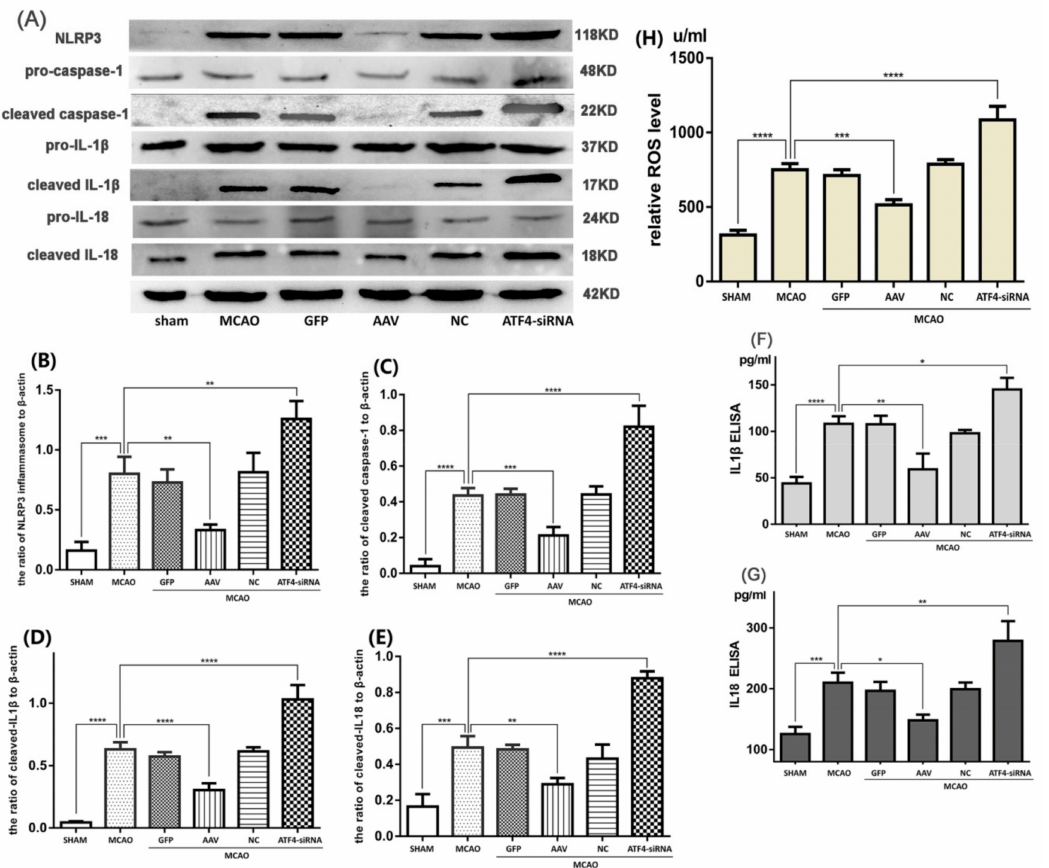
Figure 2. ATF4 a ff ects NLRP3 inflammasome-mediated inflammatory response during cerebral I / R injury. ( A – E ) Representative Western blots showing protein levels of NLRP3 protein, cleaved-caspase-1, cleaved-IL-1 β and cleaved-IL-18. Protein levels were normalized to β -actin. ( F , G ) The cytokine levels of IL-1 β and IL-18 were quantified by ELISA assays. ( H ) The levels of ROS production in the cortex were quantified by a commercial Detection Kit of Reactive Oxygen Species in Tissue. Error bars represent mean ± SD. (* p < 0.05, ** p < 0.01, *** p < 0.001 and **** p < 0.0001 vs. indicated group). n = 5 in each group. MCAO, middle cerebral artery occlusion-reperfusion; GFP, green fluorescent protein; AAV, ATF4 overexpression adeno-associated virus; siRNA, small interfering RNA; NC, negative control